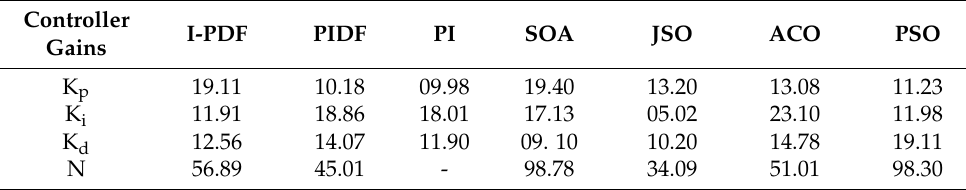
Table 1. Parametric values of proposed